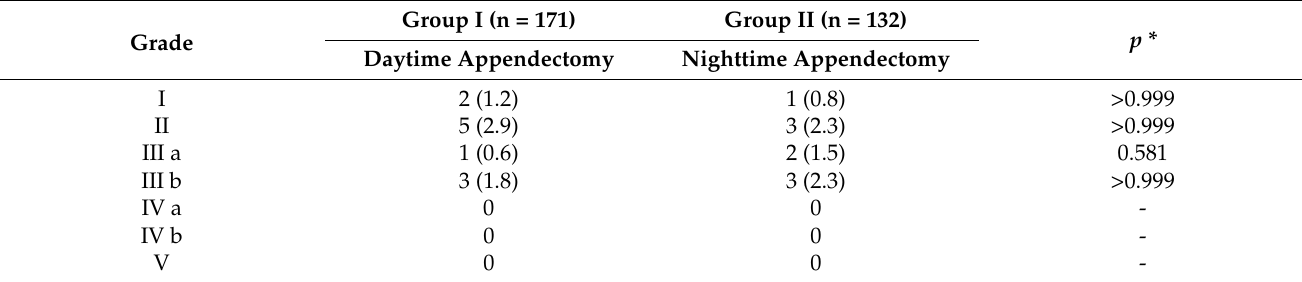
Table 4. The Clavien–Dindo classification of postoperative